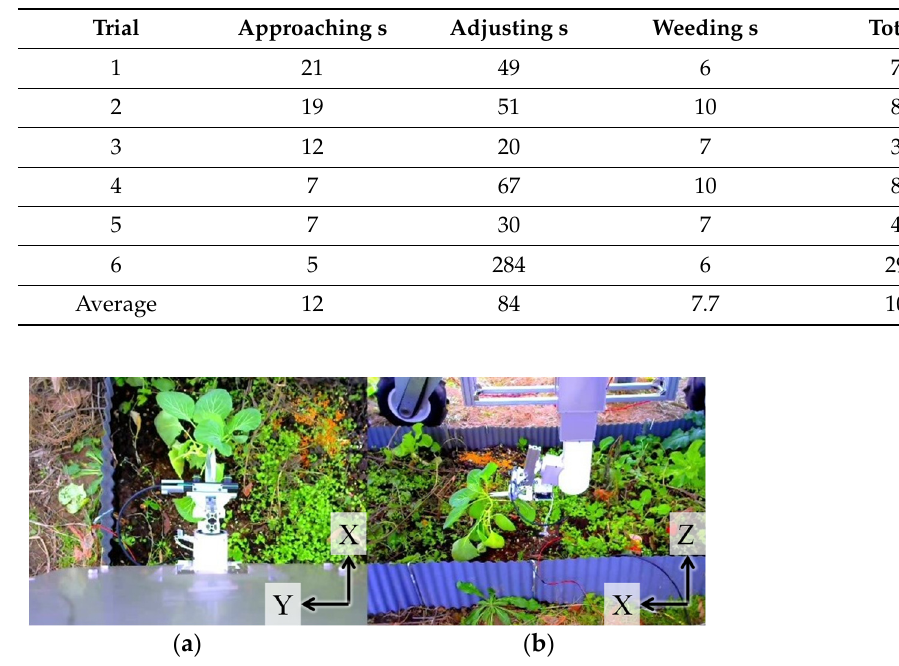
Table 3. Time of pruning experiment.